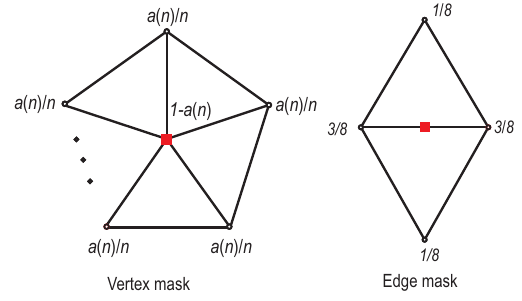
Fig. 1 Loop subdivision masks. Left: vertex mask. Right: edge mask.